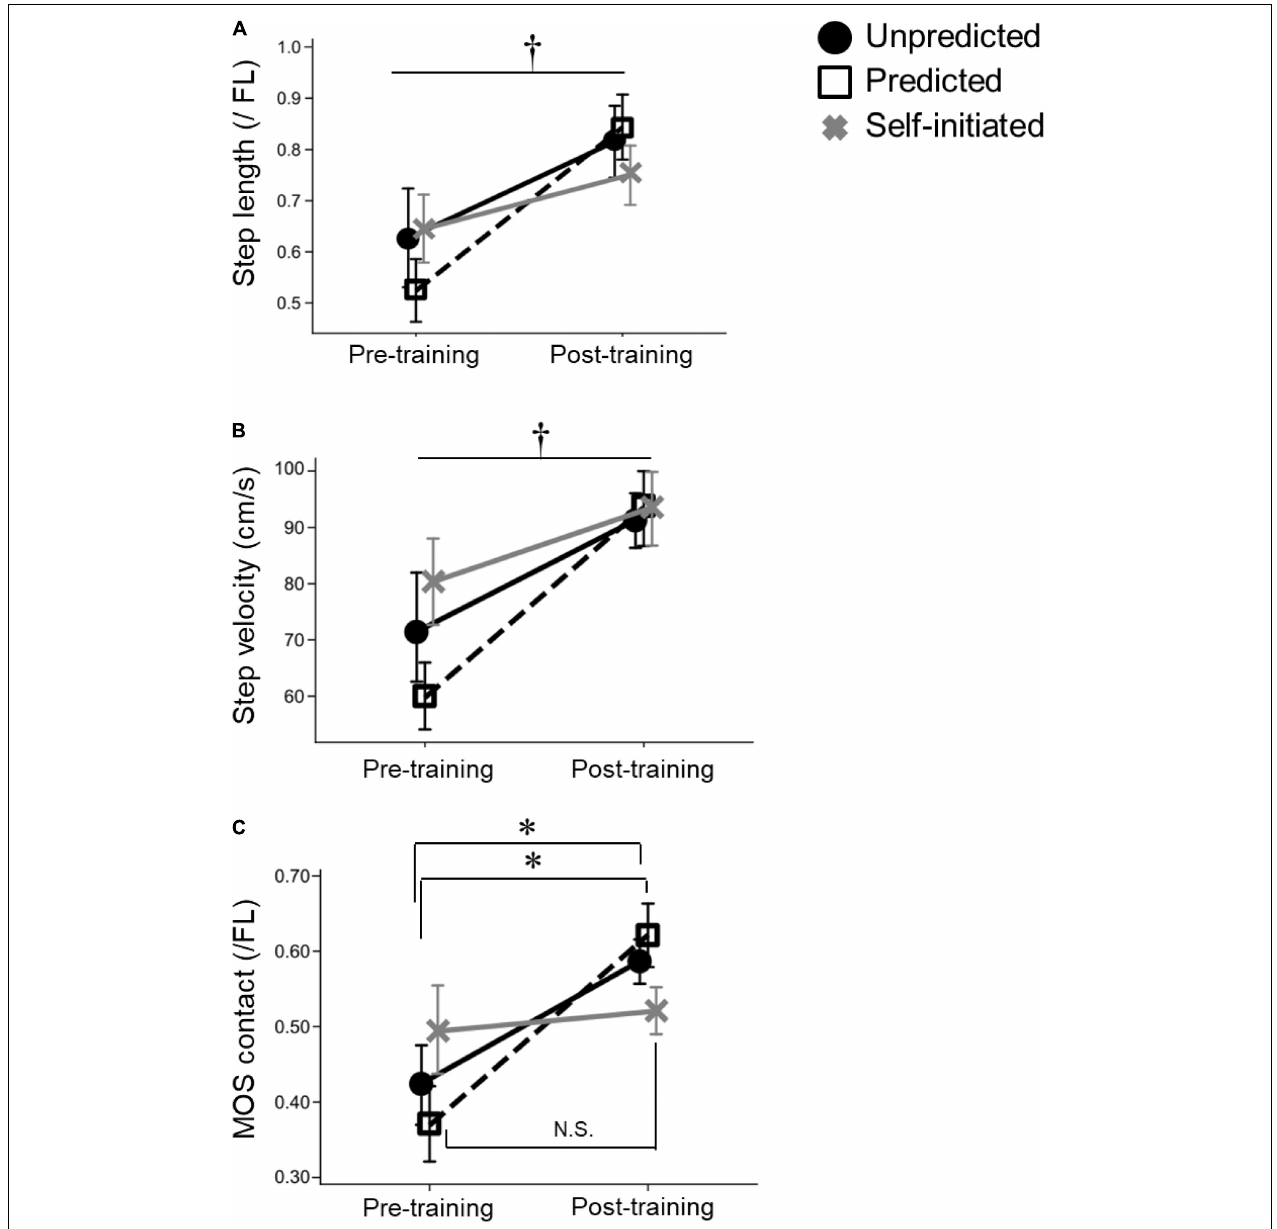
FIGURE 3 | Significant effects of Unpredicted and Predicted step training on stepping outcomes and margin of stability. Mean and standard error of mean plots of two stepping outcomes (A,B) and one MOS outcome (C) : (A) Step length, (B) Step velocity, and (C) MOS at initial contact. Black circles represent the Unpredicted step training group, white squares represent the Predicted step training group, and gray crosses represent the Self-initiated step training group. Error bars show the SEM, (*) indicate p -values less than 0.05 on post hoc analysis, and the ( † ) indicates a significant main effect of the Test session. MOS, margin of stability; SEM, standard error of mean ( standard deviation / p the number of participants ); N.S., non-significance; FL, foot